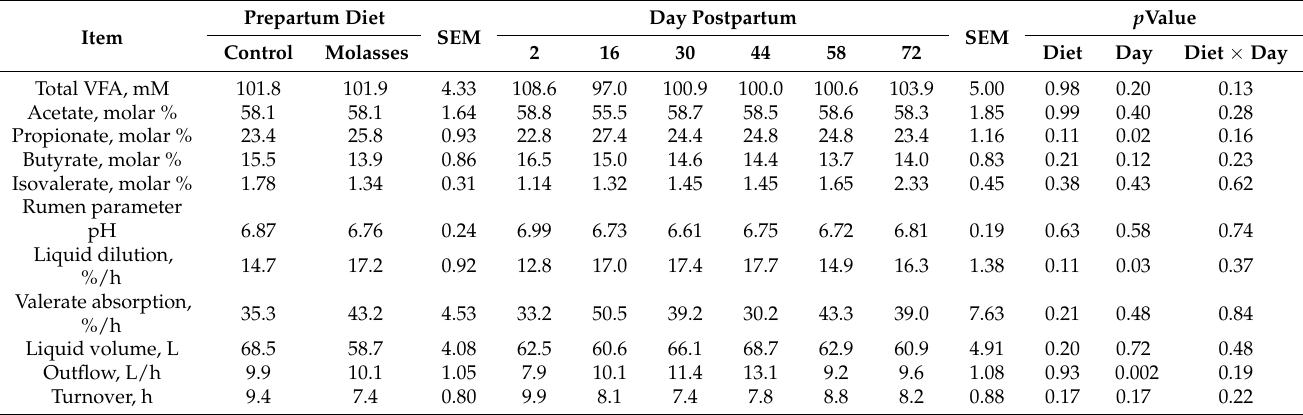
Table 12. Rumen fluid volatile fatty acids proportions, pH, and kinetics during the postpartum period for cows fed either a control or a molasses-containing diet during a 60 day dry period (Experiment